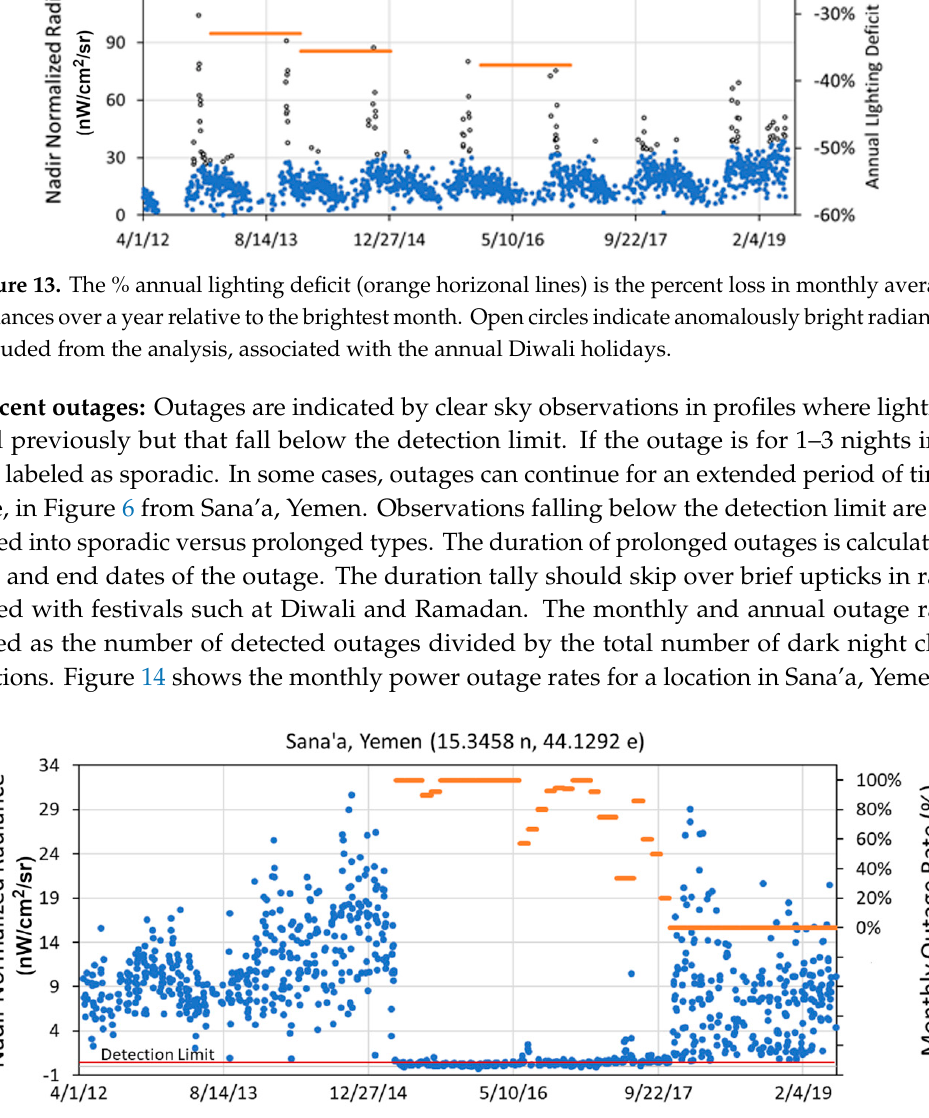
Figure 14. Monthly outage rates (orange horizontal lines) following the aerial bombing of Sana’a, Yemen, in late March, 2015. Following the bombing, the outage rates jumped to 100% for 10 of the first 12 months. Small radiance spikes are associated with Ramadan in 2016 and 2017, plus a slight rise in radiance above the detection limit resulted in fluctuating monthly outage rates starting from June 2016. The last recorded outage event was 28 October